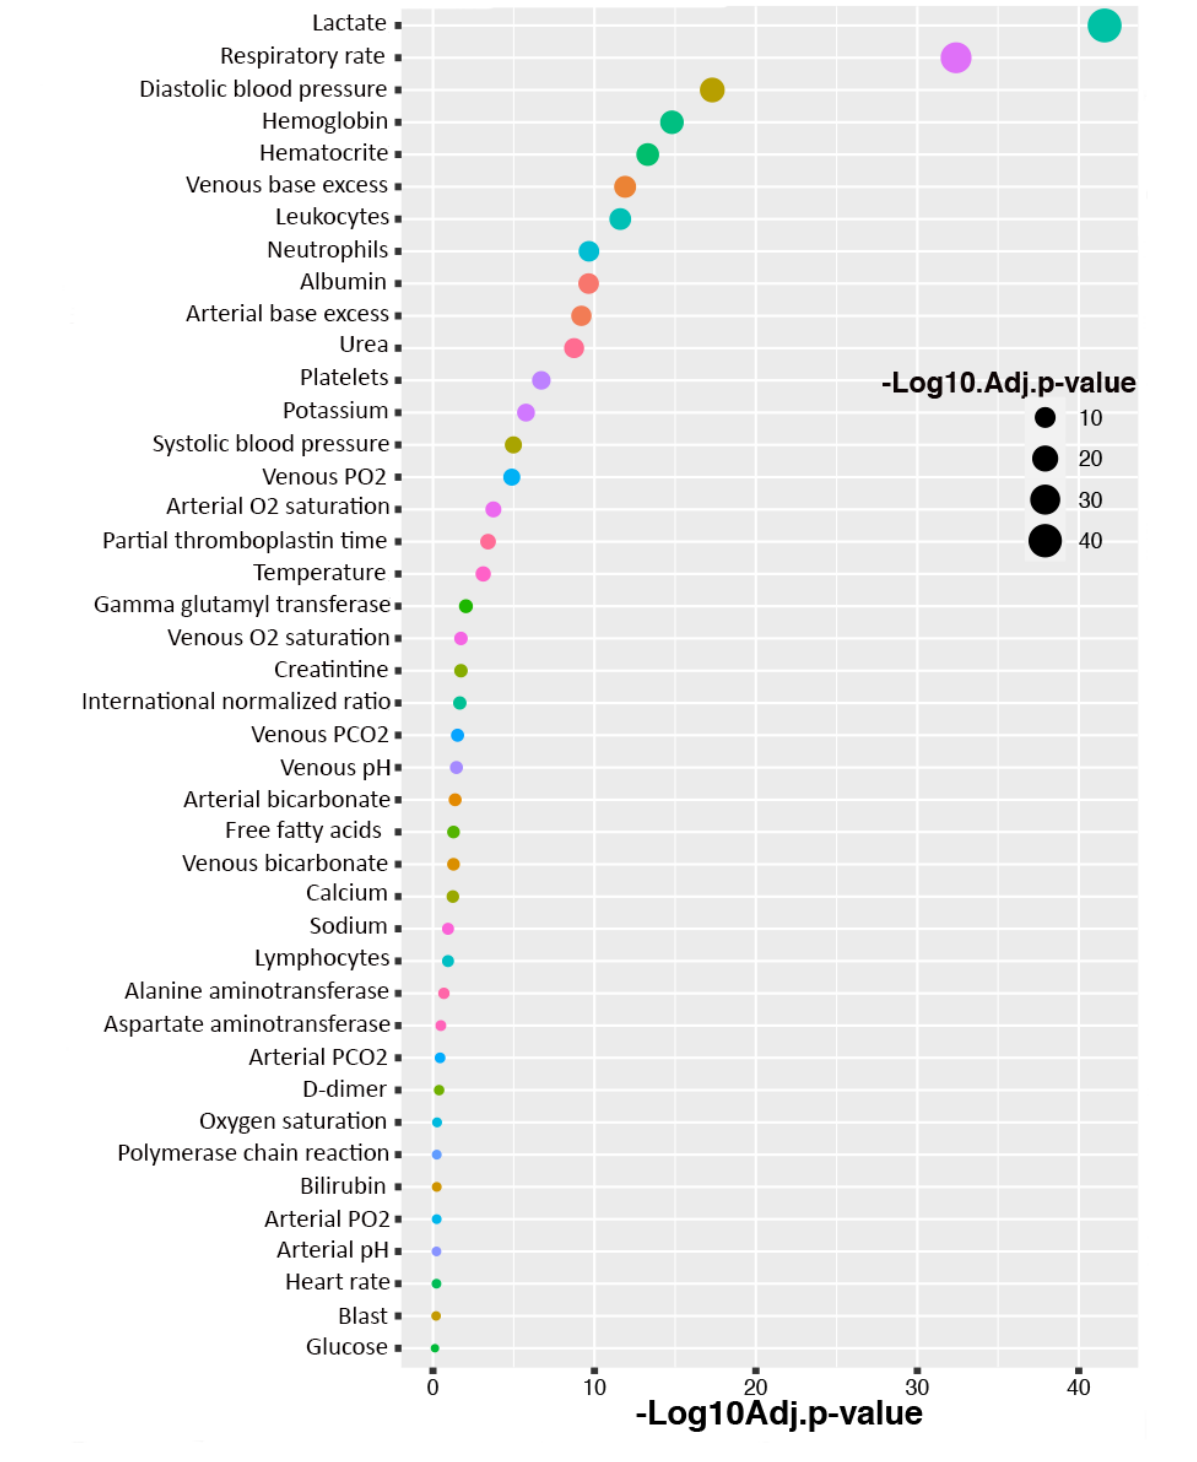
Figure 4. Association of blood parameters with the severity of COVID-19 disease. Associations and significant differences (using t tests) between the patients with severe COVID-19 and nonsevere COVID-19. Adj.p-value: adjusted P value; D-dimer: dimerized plasmin fragment D; FFA: free fatty acids; GGT: gamma-glutamyl transferase; INR: international normalized